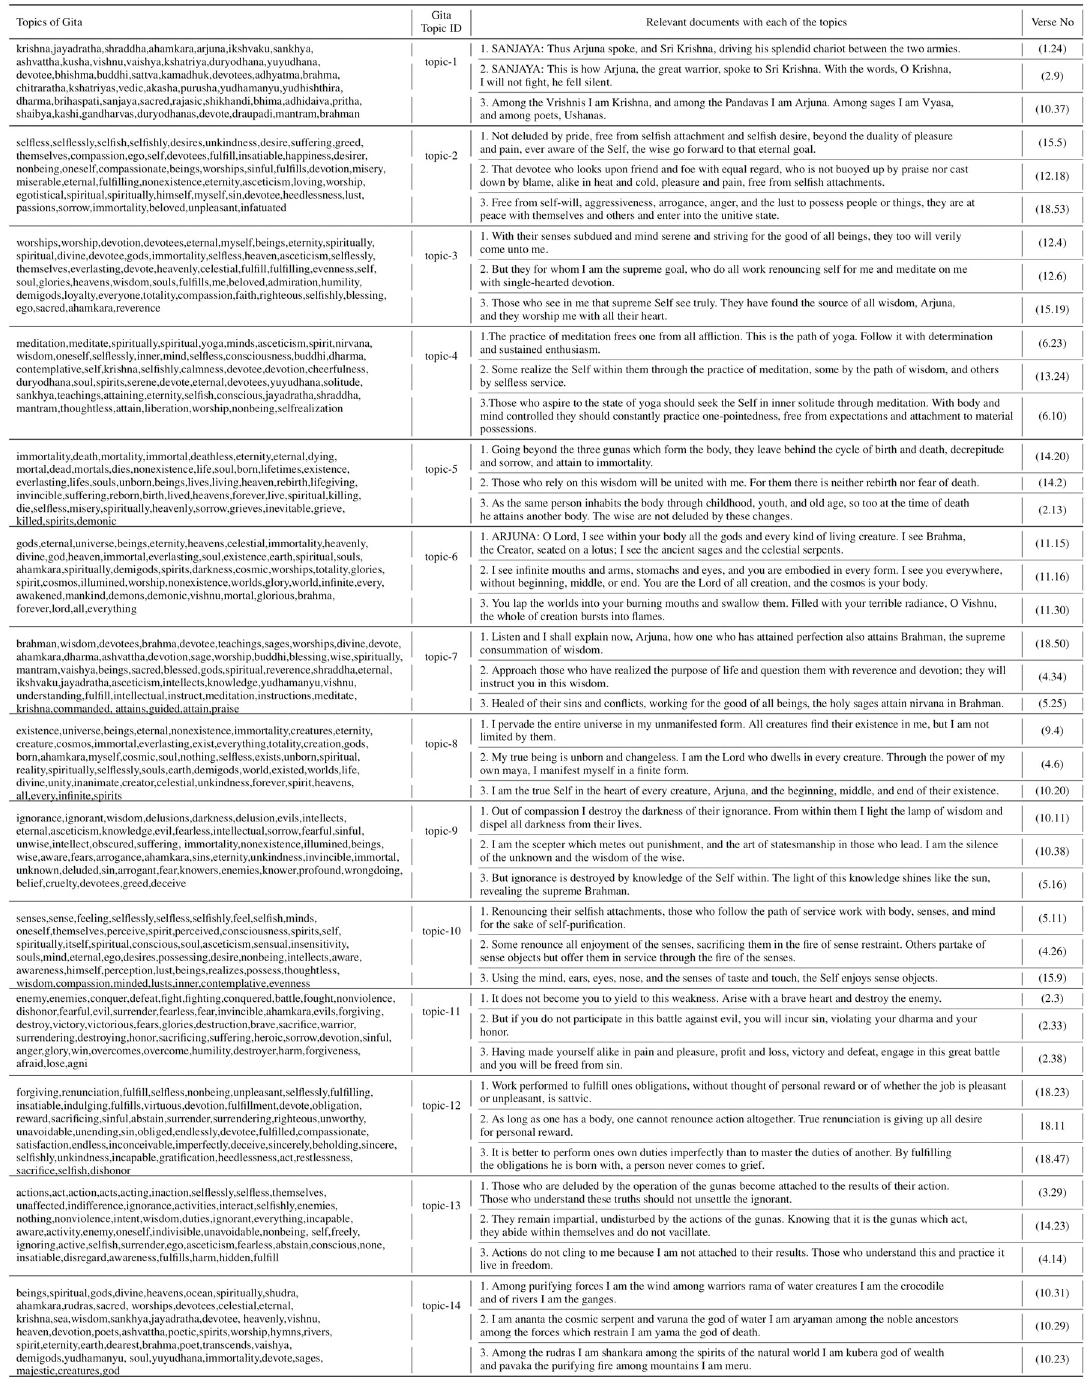
Fig 7. Topics of Bhagavad Gita and the most relevant documents(Model: USE-HDBSCAN-UMAP). evaluators rate the topic quality on a three-point topic quality score, and 2.) intrusion, where each topic is represented by its top words along with an intruding word which has a very low probability of belonging to the topic since it does not belong in the topics uncovered. It is a behavioural way to judge topic coherence and is measured by how well a human evaluator can